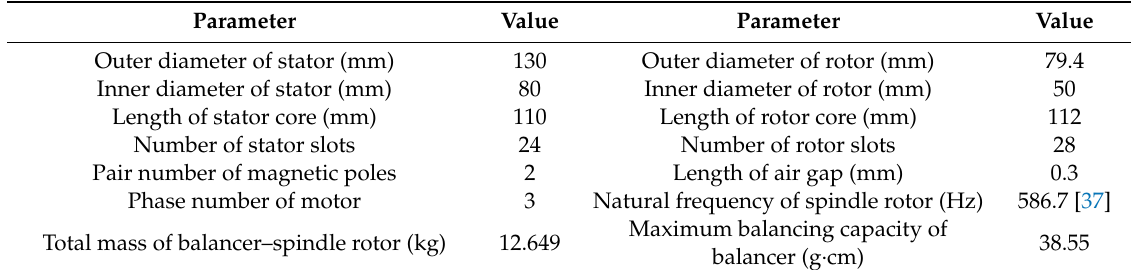
Table 3. Main design parameters of ZYS-170MD12Y16 motorized spindle.